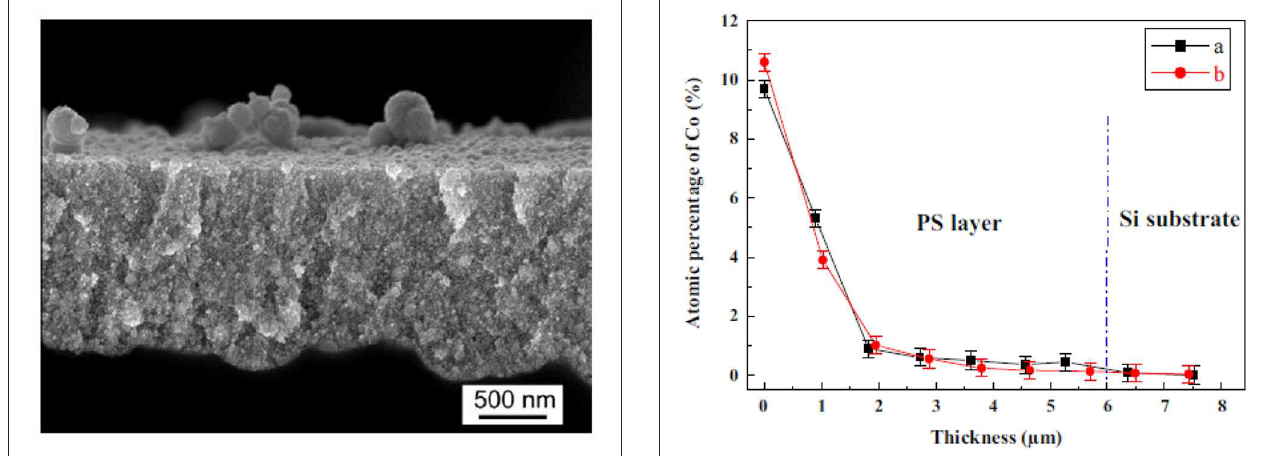
FIGURE 2 | Depth dependence of the atomic percentage of Co obtained from EDX measurements showing (a) sample before temperature treatment and (b) after annealing at 400 ◦ C. Bouzouraa et al. [ 27], Elsevier by permission.